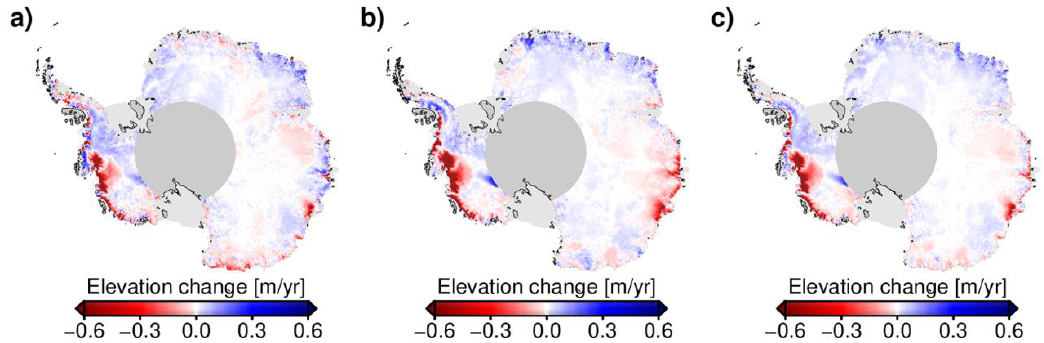
Figure 3. Maps of the long-term elevation changes from the combined elevation time series over the periods of 2002–2010 ( a ), 2010–2019 ( b ) and 2002–2019 ( c ). periods of 2002–2010 ( a ), 2010–2019 ( b ) and 2002–2019 ( c